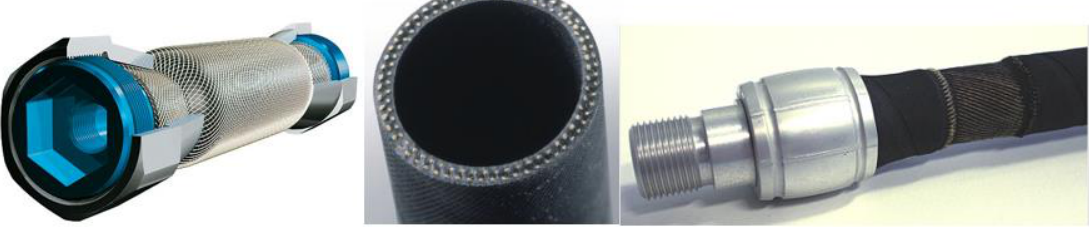
Figure 1. Construction and structure of a Festo pneumatic muscle.